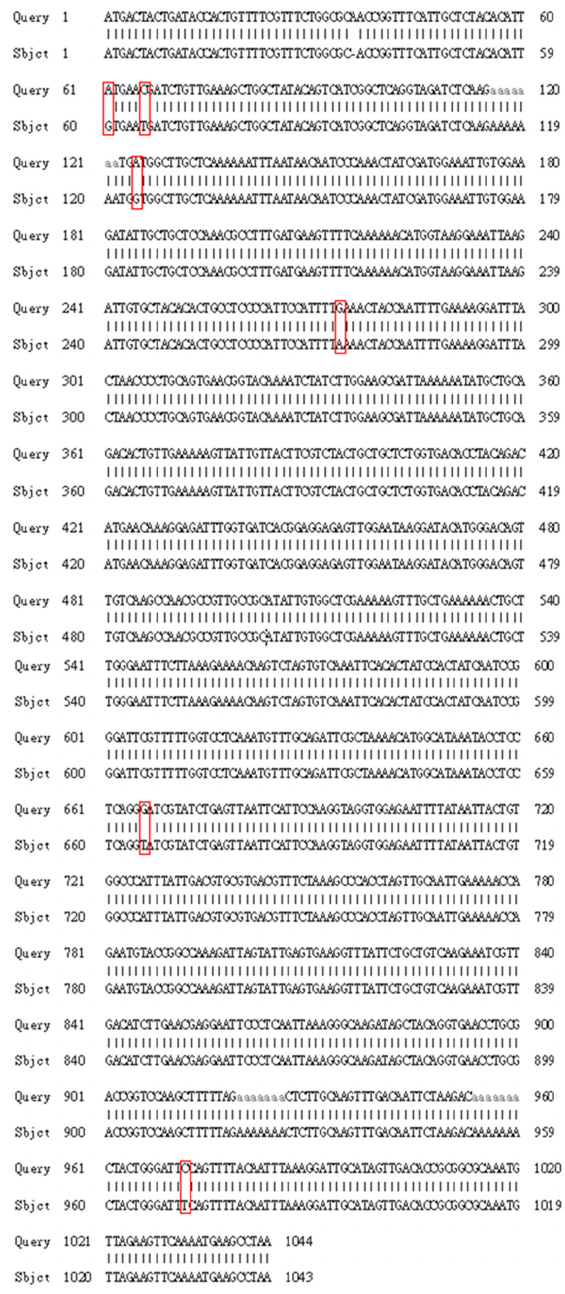
Figure 1. Comparison of the ari1 DNA sequence for ari1 obtained in this study with that published by Liu et al., 2009. Query: The ari1 DNA sequence published by Liu et al., 2009. Subject: The ari1 DNA sequence from this study. It is shown that the DNA sequence of this study is different from that of Liu et al.